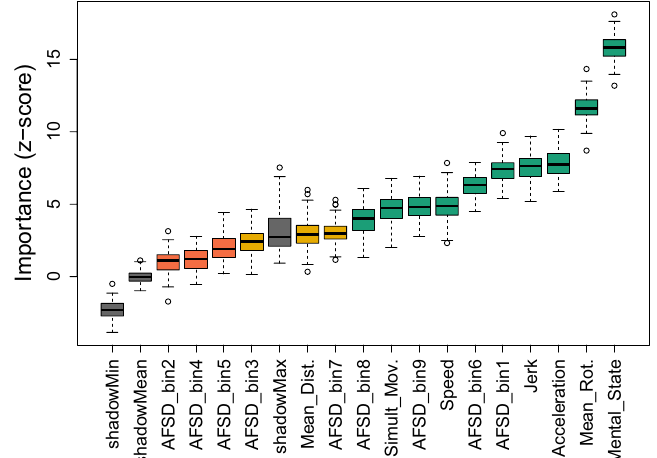
Figure 4. Random forest variable importances. Variable importances of all 16 features entered into the Boruta random forest, displayed as boxplots. Box edges denote the interquartile range (IQR) between first and third quartile; whiskers denote 1.5 * IQR distance from box edges; circles represent outliers outside of 1.5 * IQR above and below box edges. Box color denotes decision: Green = confirmed, yellow = tentative, red = rejected; grey = meta-attributes shadowMin, shadowMax and shadowMean (minimum, maximum and mean variable importance attained by a shadow